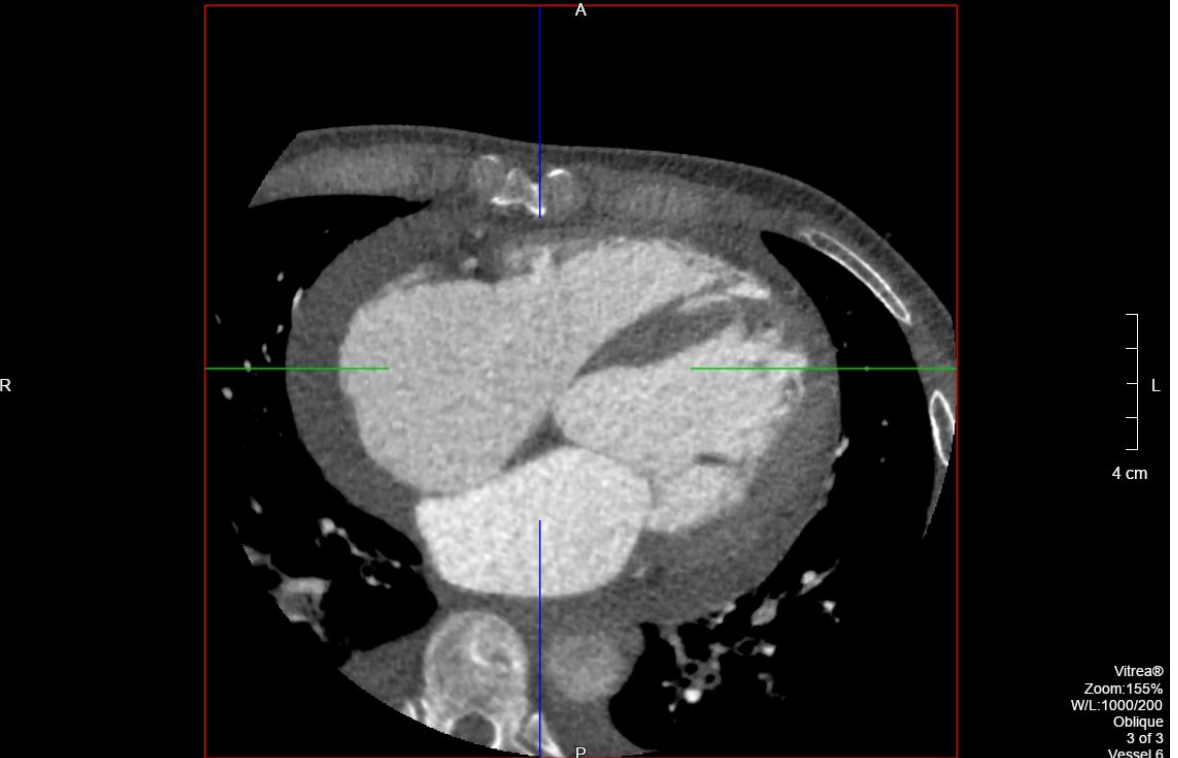
Figure 4. Segment of cardiac CT angiography demonstrating cardiomegaly and no coronary artery disease.